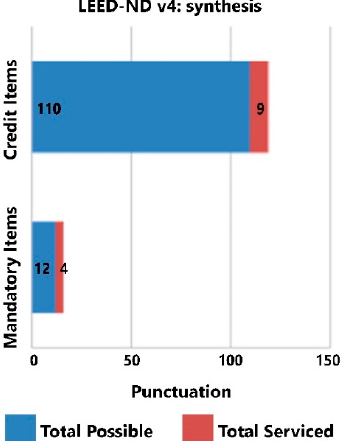
Figure 6. Numerical synthesis of the sustainability evidence found.